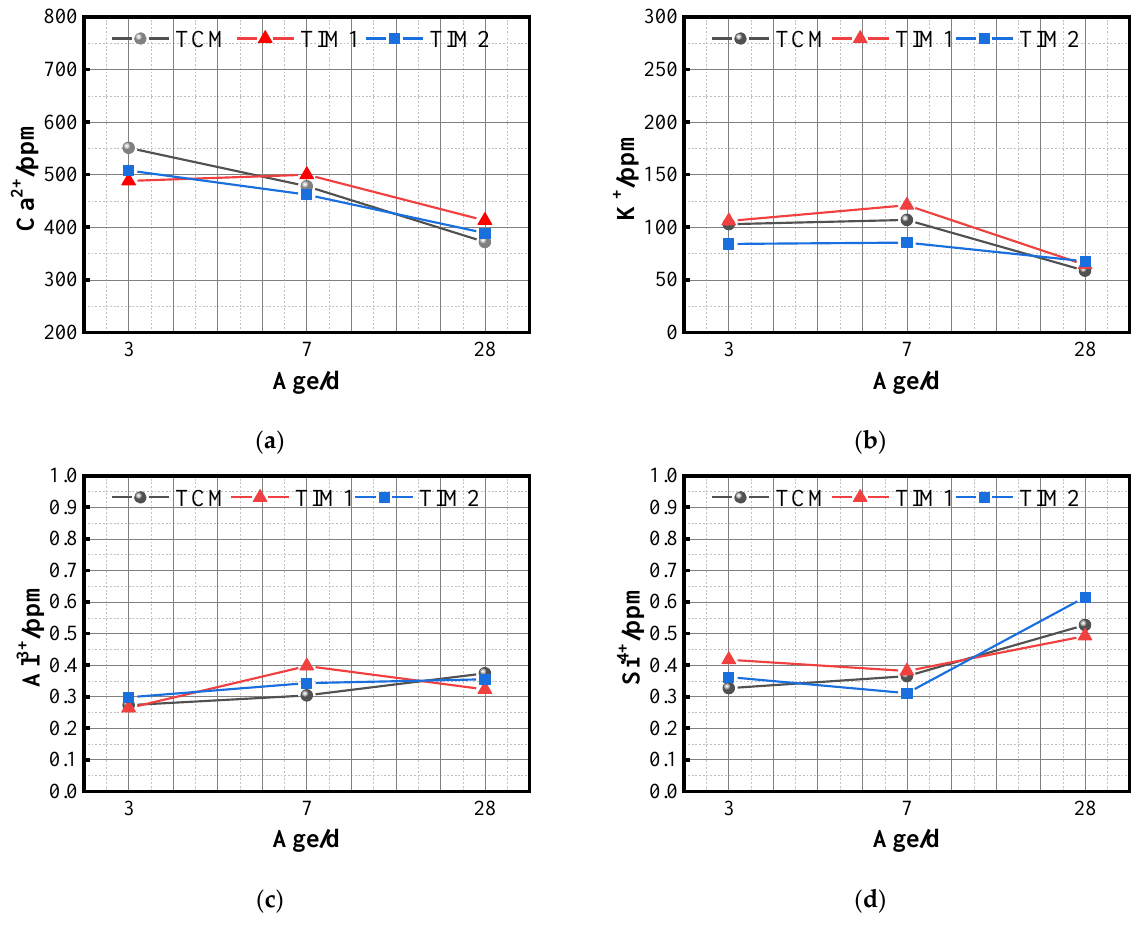
Figure 10. The concentration changes of the main ions: ( a ) Ca 2+ ; ( b ) K + ; ( c ) Al 3+ ; ( d ) Si 4+ . From Figure 10, the concentrations of free-state Ca 2+ and K + ions are higher, while the concentrations of Al 3+ and Si 4+ ions are lower. The ions of Ca 2+ and K + decrease